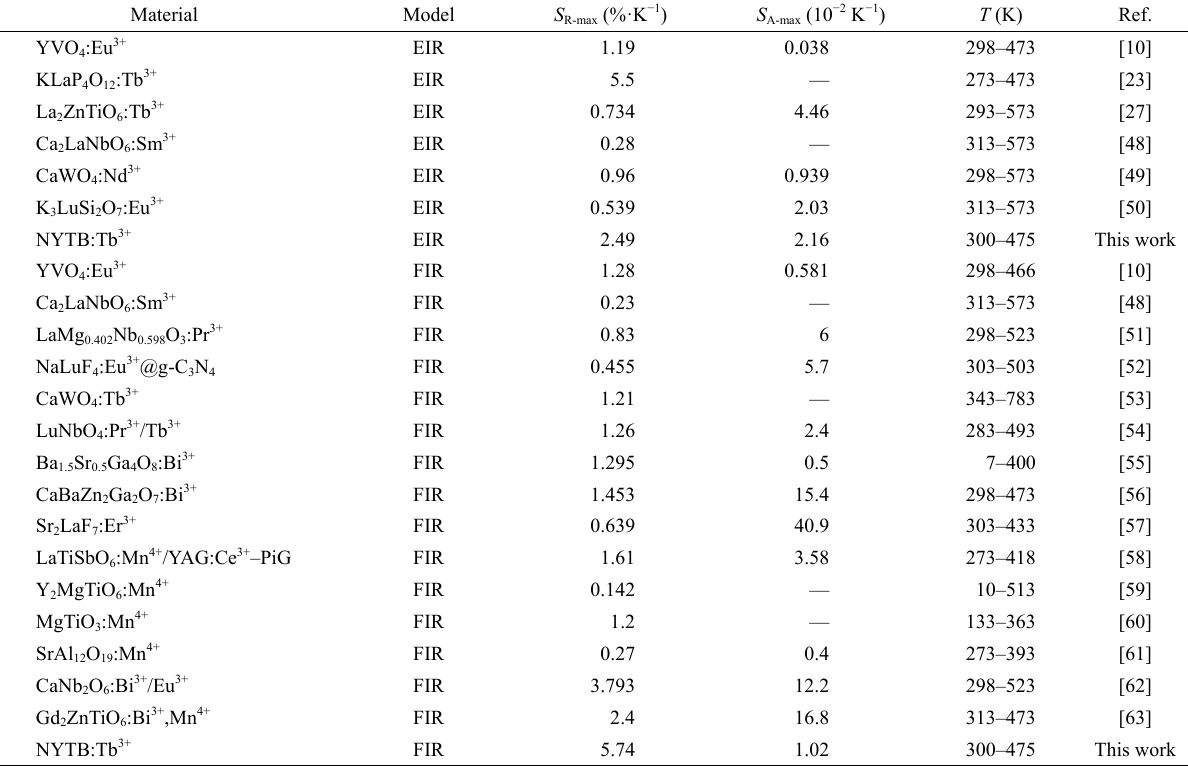
Fig. 10 (a) Thirty measurements of EIR. (b) δ T of EIR( I 378 / I 487 ). (c) Thermal repeatability between 300 and 475 K. Table 3 S R-max and S A-max parameters of reported thermometric